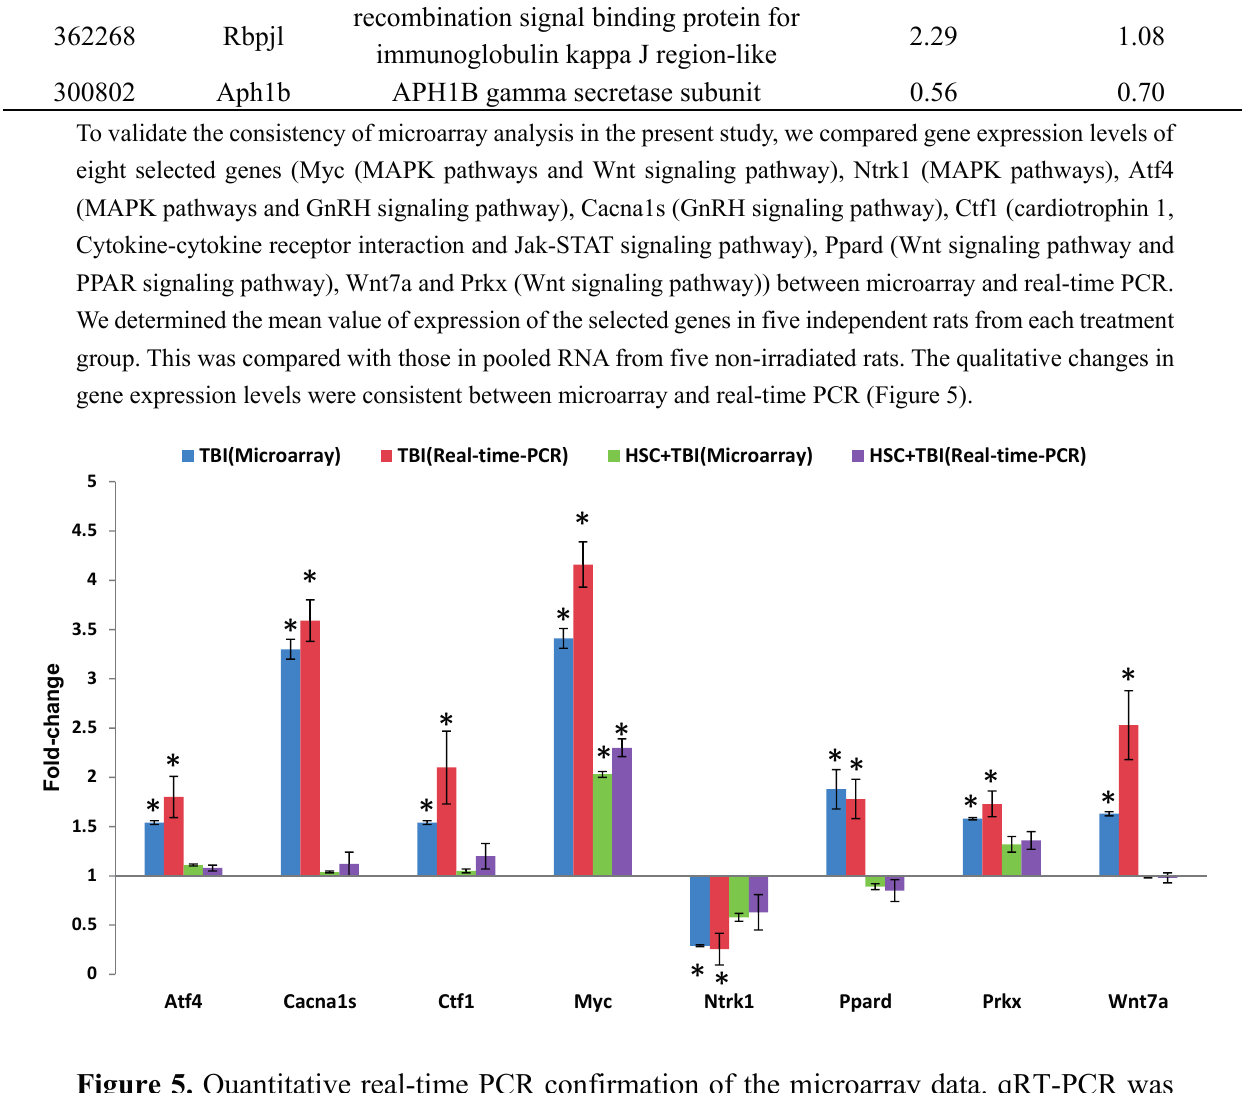
Figure 5. Quantitative real-time PCR confirmation of the microarray data. qRT-PCR was performed on eight genes where TBI-induced alteration of expression was abolished or attenuated by 10 mg/kg HSC pretreatment. RNA samples of different groups ( n = 5 per group) were prepared 24 h after exposure to 6.5 Gy TBI. Gene expression levels are shown as the mean normalized to the expression of the housekeeping gene beta-actin. Each sample was measured in triplicate. Columns, the mean of three or four rats in the microarray experiment or the mean of five rats in PCR; bars, SD. * indicates statistical significance compared to control (non-irradiation) by t -test, * p < 0.05. Comparison of fold change produced by microarray with relative expression ratio obtained from real-time PCR with good